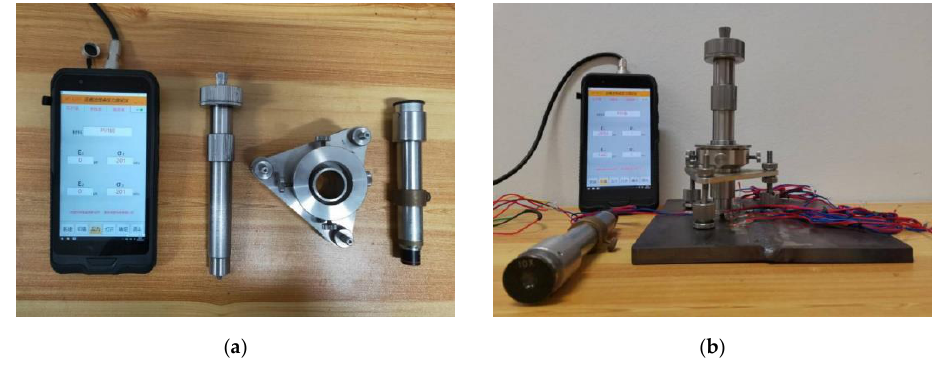
Figure 13. Position of measuring points for specimens (unit: mm): ( a ) after initial welding; ( b ) after repair welding.